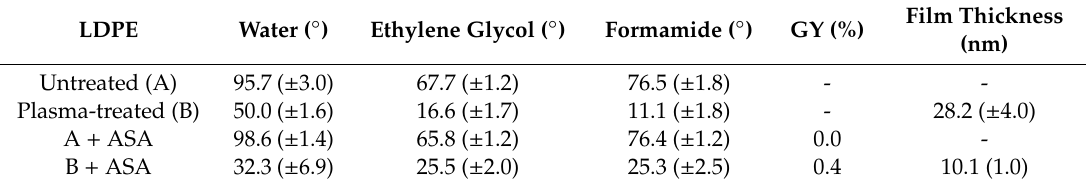
Table 1. The contact angles and graft yields of LDPE samples.